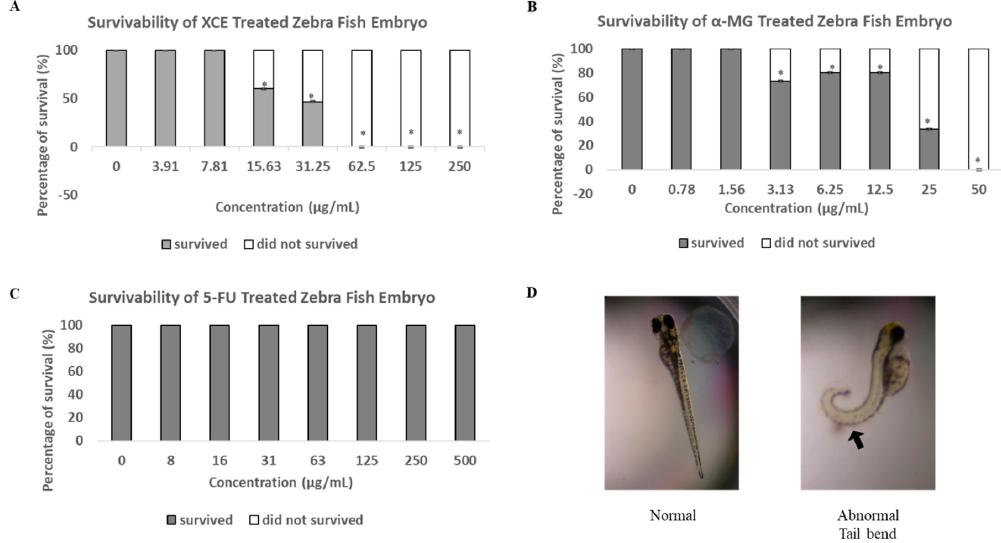
Figure 5. The toxicity of ( A ) XCE, ( B ) α -MG, and ( C ) 5-FU on zebrafish embryos. Experiments were statistically analyzed using two-tailed Student’s t-test. Asterisk (*) shows the significant ( p < 0.05) difference between the treatment group and the untreated group (the concentration of 0 µ g/mL of the compound or extract). All experiments were repeated five times. ( D ) shows the representative image of tail-bend malformation of embryos (arrow) treated with α -MG. No XCE and 5-FU treated embryos were found to exhibit any malformation.